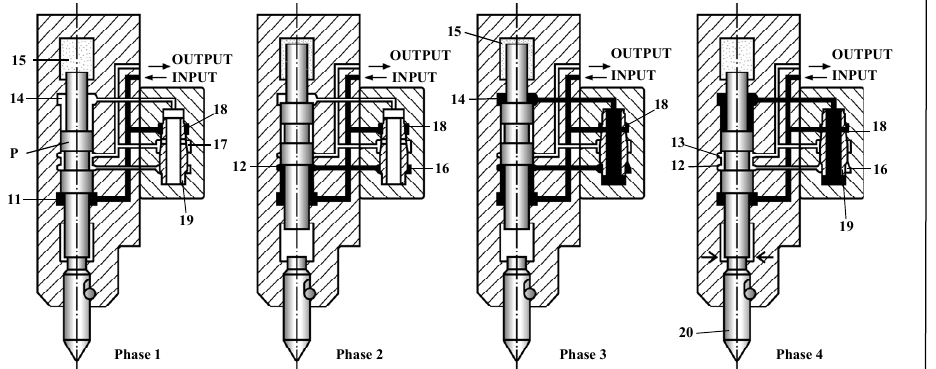
Figure 2 – Crossectional view of the hydraulic hammer and the operational phases Slika 2 – Presek hidrauli č nog č eki ć a i njegove radne